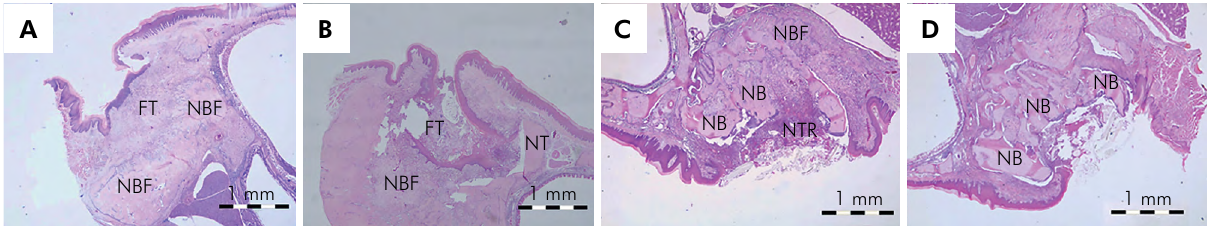
Figure 6. Histomorphometric analysis on day 21 after treatment. A) New bone formation between fibrous tissue in the extraction area in experimental group 1 (H&E x 40). B) New bone formation under the fibrous tissue in group 2 (H&E x 40). C) Negative control group. Extraction socket filled with necrotic tissue remains, as well as necrotic bone; new bone formation was observed at the extraction socket (H&E x 40). D) No treatment control group. Necrotic tissue remained within a large area surrounding the necrotic bone (H&E x 40). FT, Fibrous tissue; NBF, New bone formation; NB, New bone; NT, Necrotic Tissue, NTR, necrotic tissue